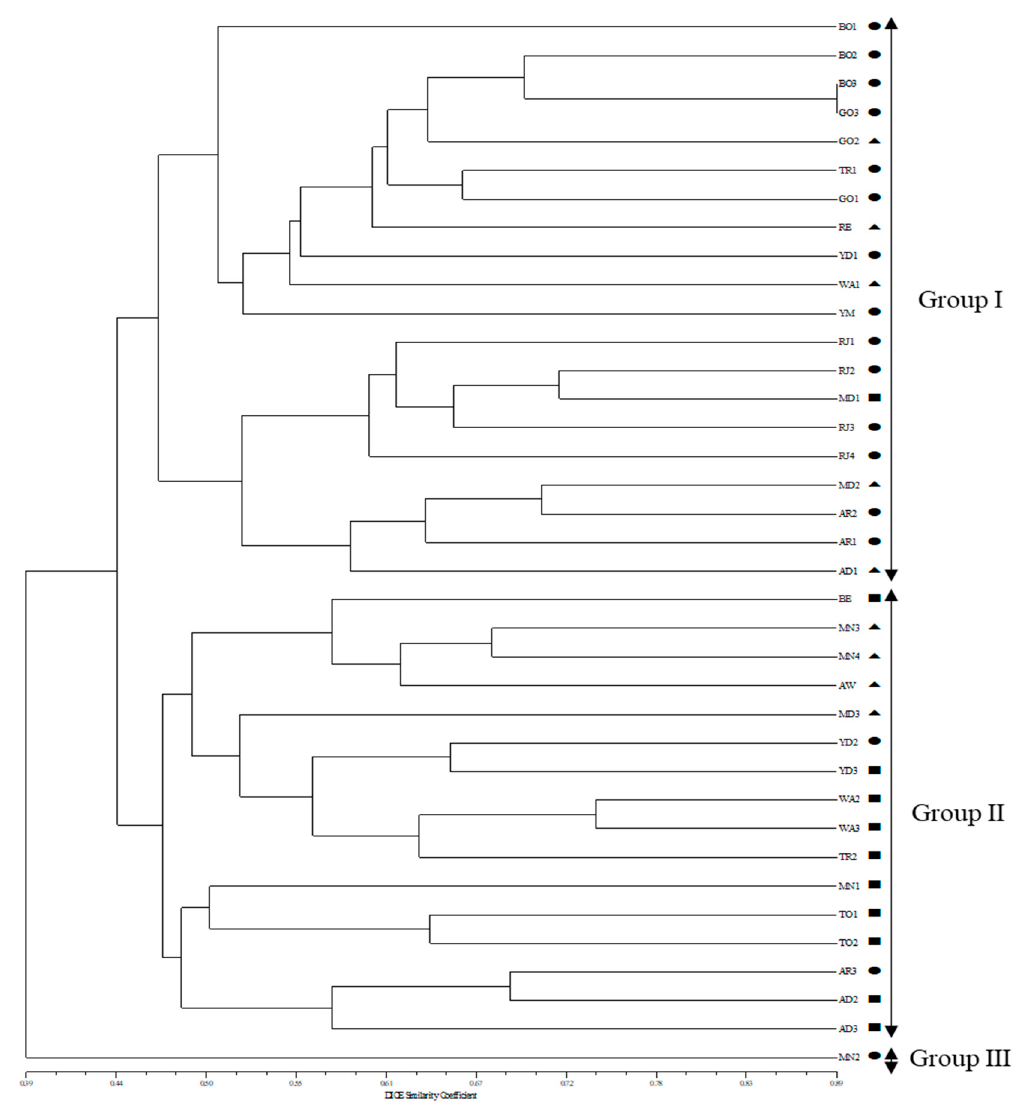
Figure 4. UPGMA dendrogram of 37 maize accessions based on 27 SSR markers ( ● : Southern region maize accessions, ▲ : Northern regions maize accessions, ■ : Central region maize accessions).